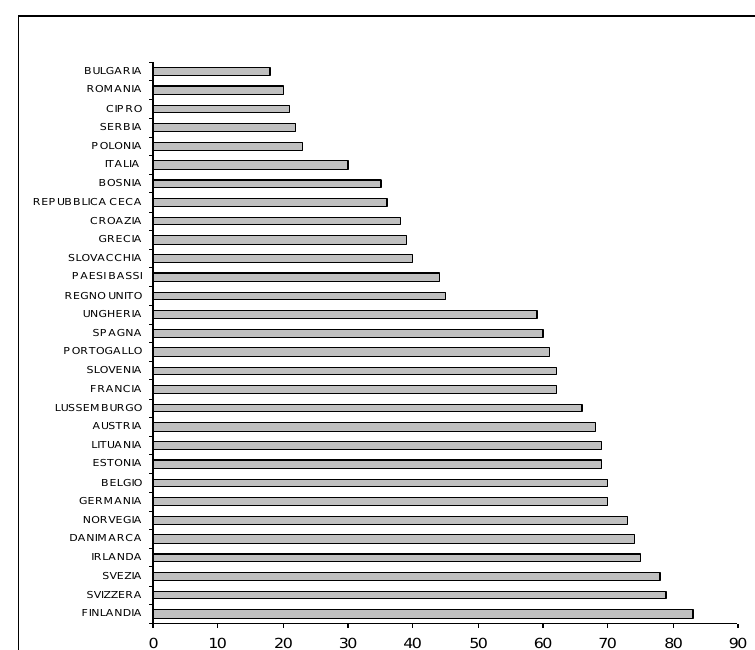
Figure 1: Market Concentration: Market Quota of The Top 5 Distributors (Year